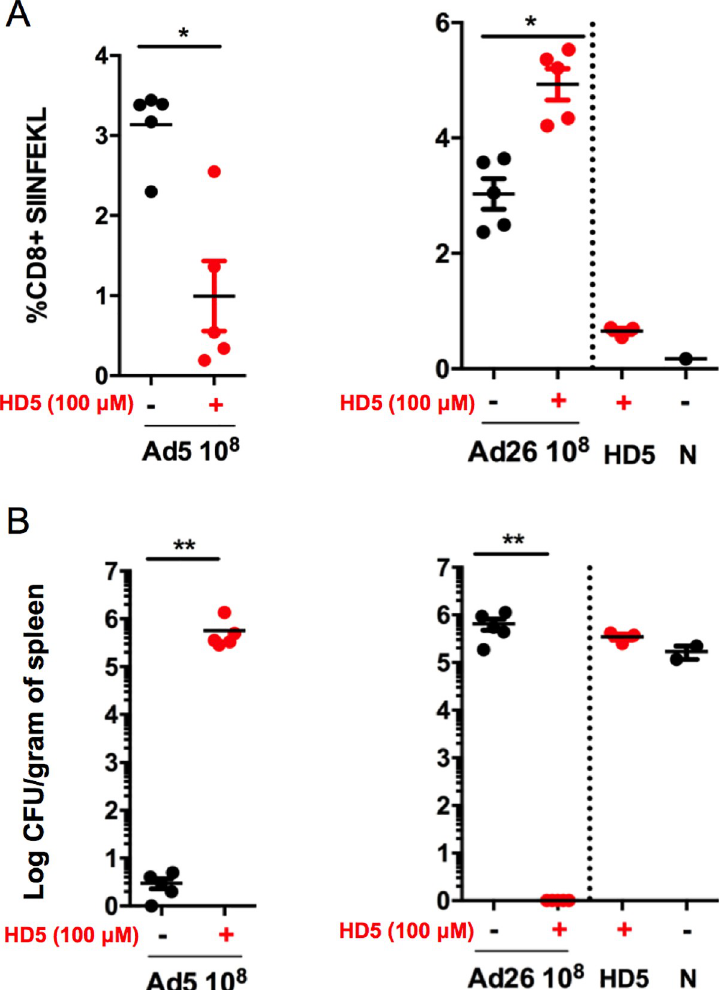
Fig 6. HD5 alters antigen-specific CD8 + T cell responses primed by Ad5 and Ad26 vectors in a recombinant Listeria monocytogenes challenge model in mice. C57BL/6 mice (n = 5/group) were administered i.m. Ad5. SIINFEKL (10 8 vp) or Ad26.SIINFEKL (10 8 vp) pretreated with either PBS or 100 μ M HD5. (A) On day 11 after immunization, mice were bled and SIINFEKL-specific CD8+ T cell responses were measured by H-2K b tetramer staining. Following bleeding, animals were challenged with 1.0 X 10 5 CFU Lm -OVA. (B) The mean number of bacteria per spleen was determined 48 h after Listeria monocytogenes infection. The data are representative of experiments performed two times. Mean ± SEM are shown. �� p < 0.01, � p < 0.05, Mann-Whitney U Test (compared to virus only